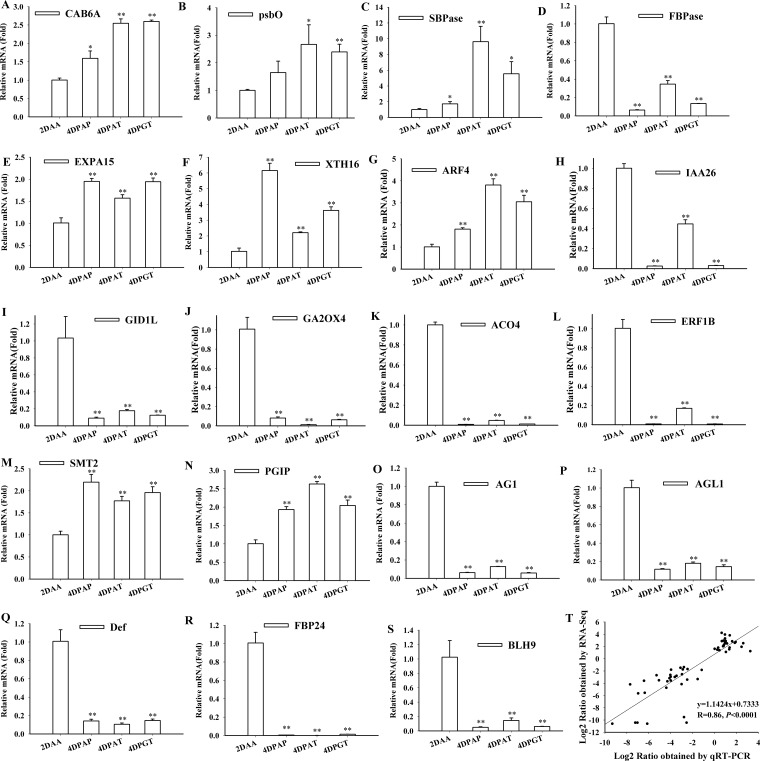
Expression patterns of selected genes identified by RNA-Seq were validated by qRT-PCR.Expressions of selected genes related to photosynthesis (A) CAB6A and (B) psbO, carbohydrate metabolism (C) SBPase and (D) FBPase, cell expansion (E) EXPA15 and (F) XTH16, auxin signaling (G) ARF4 and (H) IAA26, GA metabolism and signaling (I) GID1 and (J) GA2OX4, ethylene biosynthesis and signaling (K) ACO4 and (L) ERF1B, BR regulation(M) SMT2 and (N) PGIP, MADS-Box proteins (O) AG1, (P) AGL1, (Q) Def and (R) FBP24, homeobox (S) BLH9 in ovaries at 4DPAP, 4DPAT and 4DPGT were analyzed by qRT-PCR. Relative expression levels were determined based on the reference 2DAA set to 1. Error bars represent means ± SE (n = 3). Statistical significance was carried out by student’s t-test. Different asterisks indicate different significant levels, one asterisk (*) for P < 0.05 and two asterisks (**) for P < 0.01. (T) RNA-Seq validation by qRT-PCR. Correlation between the RNA-Seq data and the qPCR results were revealed by regression analysis.